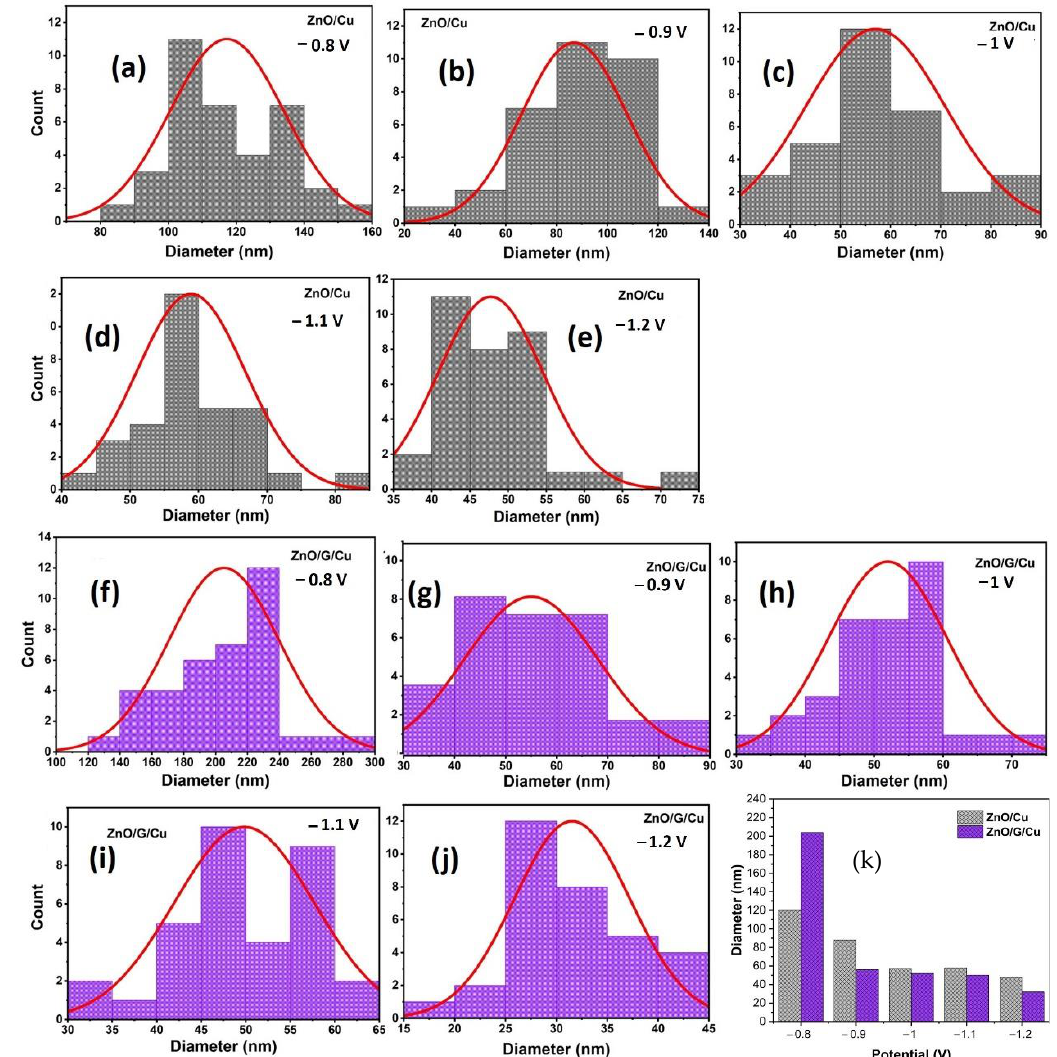
Figure 8. Diameter size distribution of ZnO nanowires deposited on Cu ( a – e ) and G/Cu ( f – j ) at different potentials, ( k ) average diameter size of ZnO nanowires as function of deposition potential for both types of electrodes.